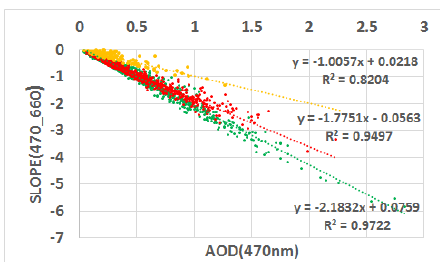
Figure 1. AOD aerosol slope (0.47 & 0.66 μ m) for Dust, AP and BB with AOD (0.47 μ m).